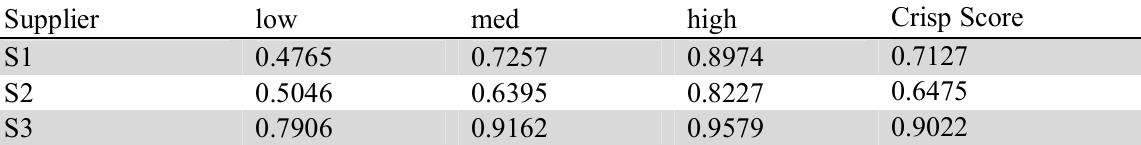
Overall score of each supplier